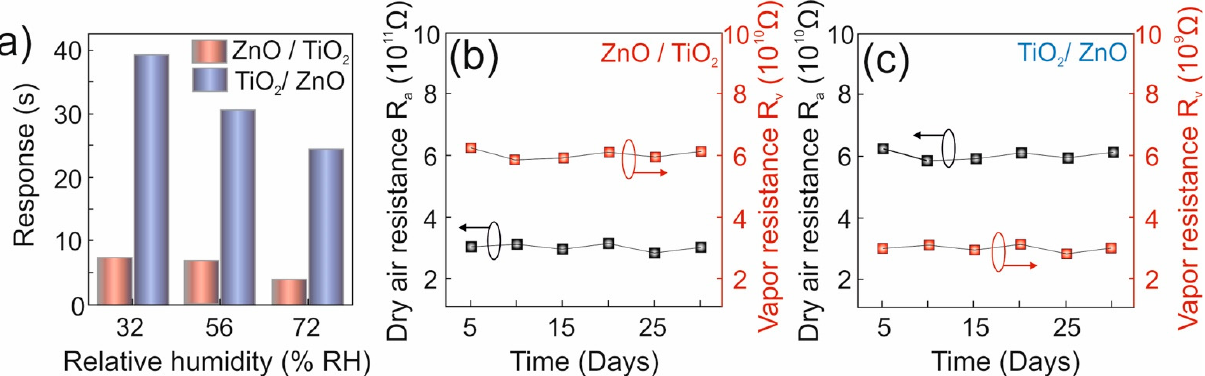
Figure 8. ( a ) Impact of relative humidity on sensing response. Performance stability of samples ZnO/TiO 2 ( b ) and TiO 2 /ZnO ( c ) towards 100 ppm of 2-propanol and ethanol over time,